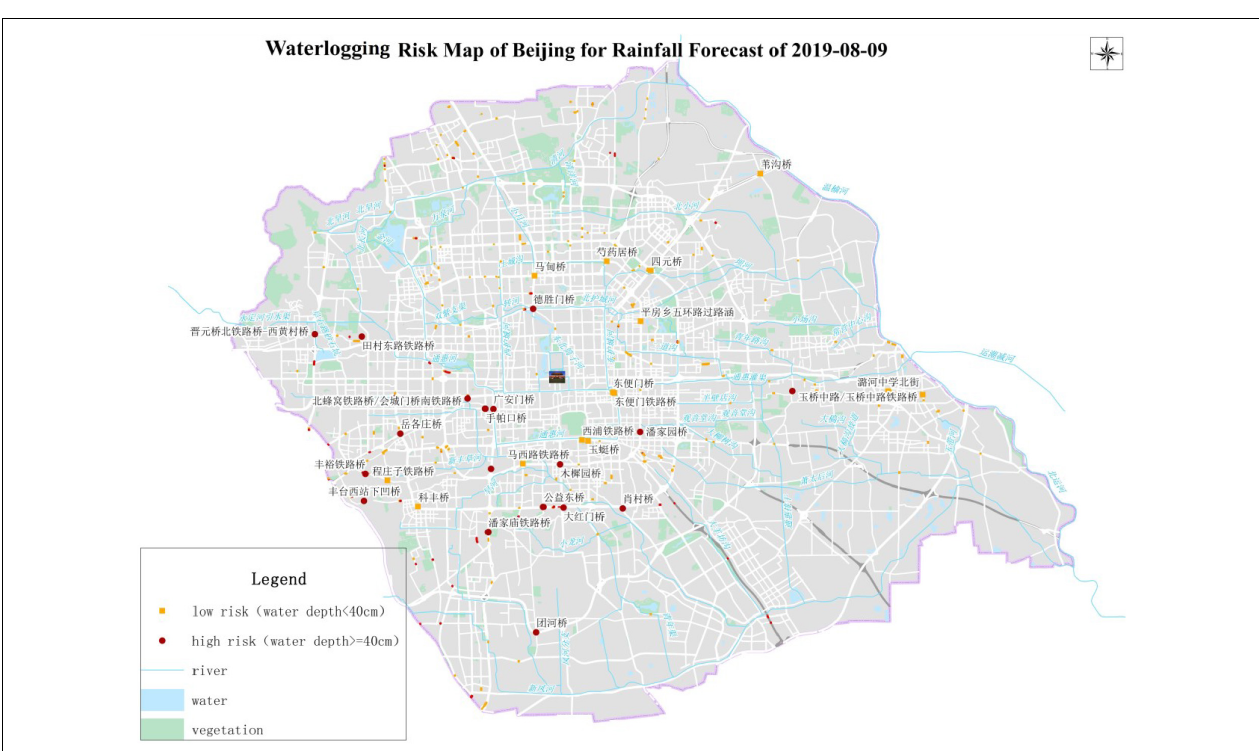
FIGURE 5 | Waterloggin risk map of a forecast rainfall in Beijing